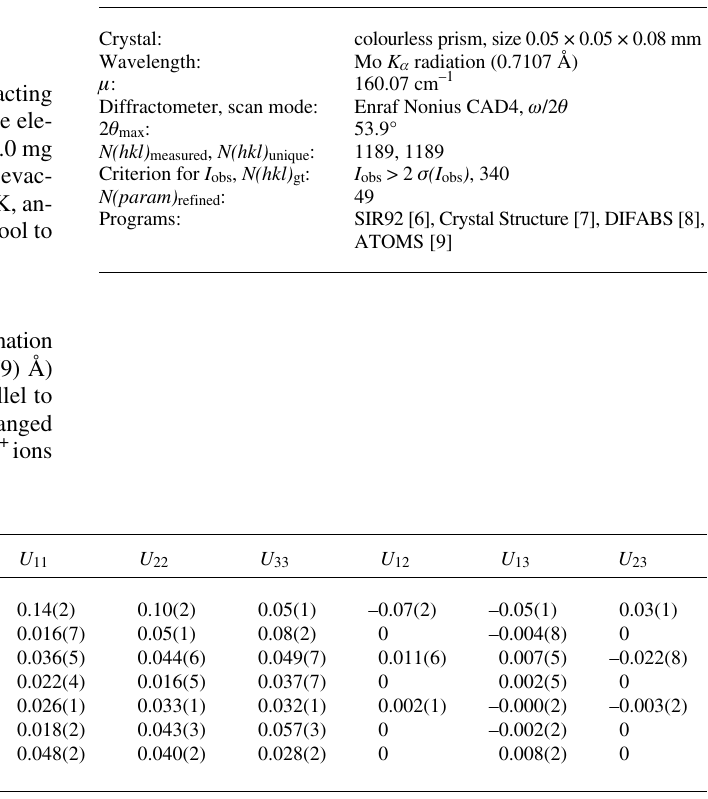
Table 1. Data collection and handling.